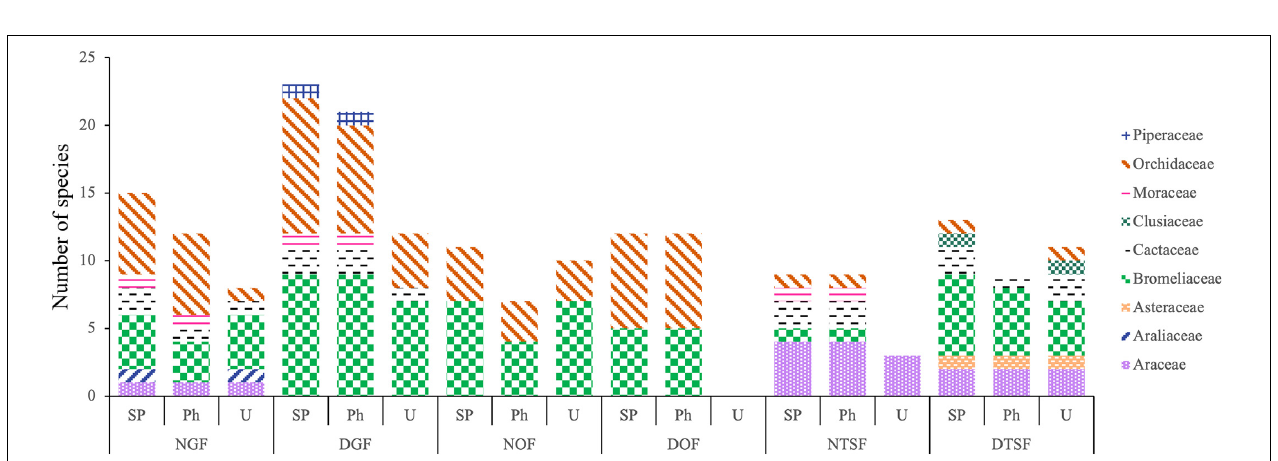
FIGURE 3 | Accumulation curves of epiphytic angiosperm species for the six sampling sites (NGF = natural gallery forest, DGF = disturbed gallery forest, NOF = natural oak forest, DOF = disturbed oak forest, NTSF = natural tropical sub-deciduous forest, DTSF = disturbed tropical sub-deciduous forest).